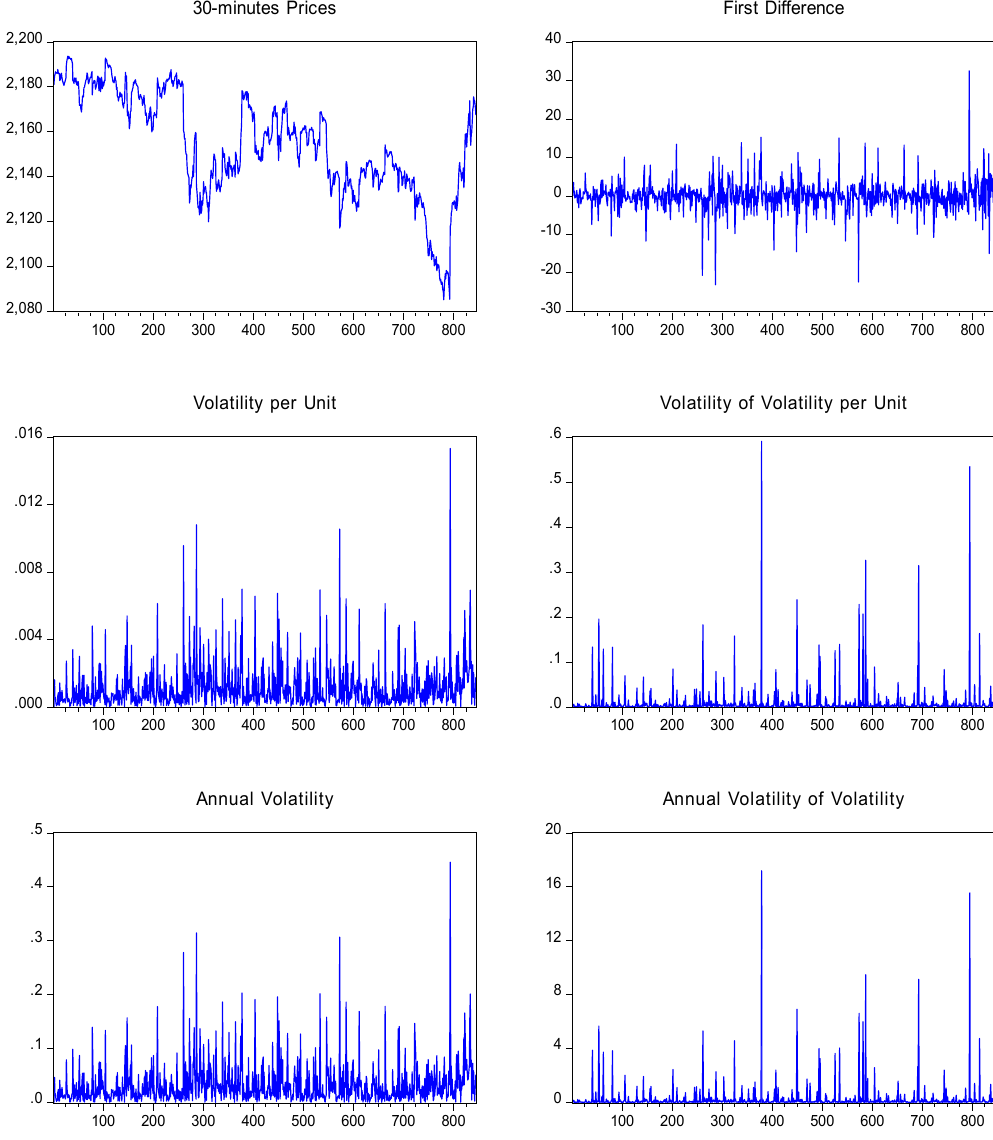
Figure 3. Plot of the S&P 500 30-min sample.